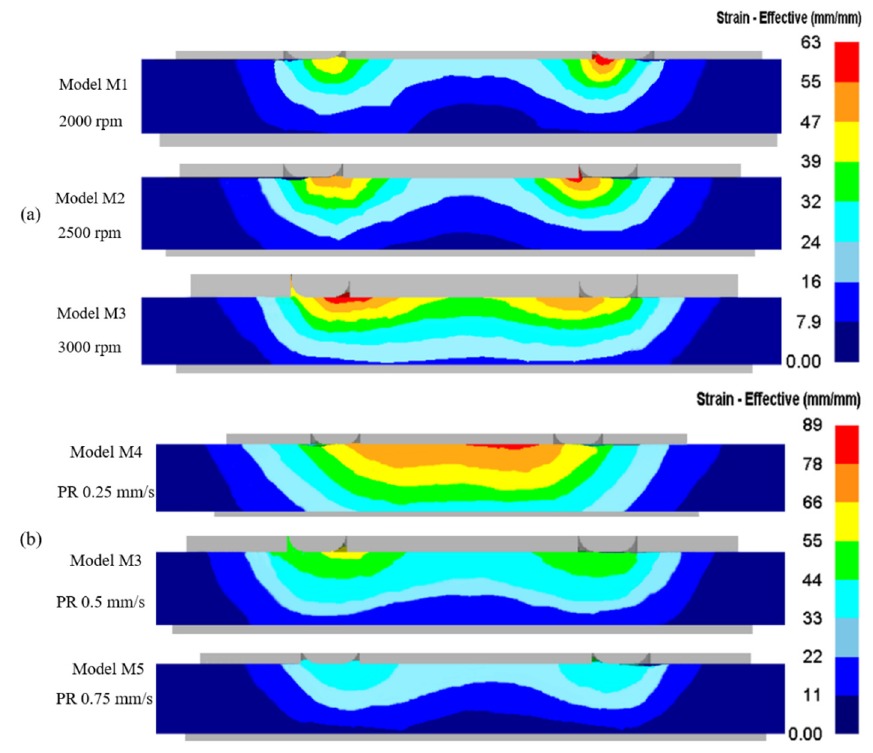
Figure 5. Comparison of effective strain contours at the process’ completion ( a ) at different RSs; ( b ) at different PRs.